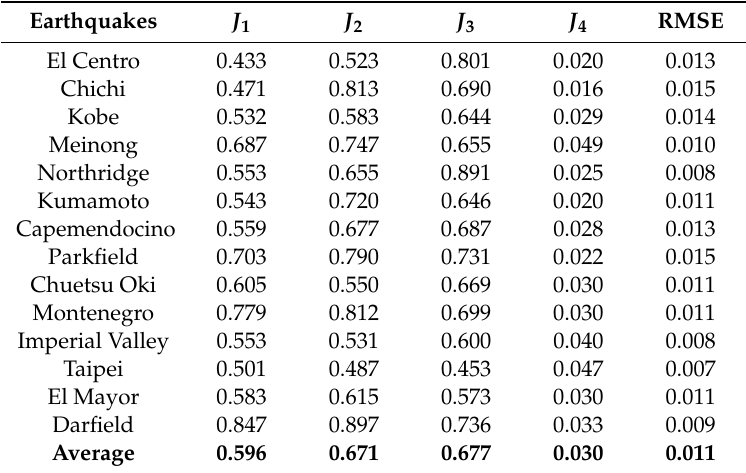
Table 5. Seismic control performance of the MLP-150.